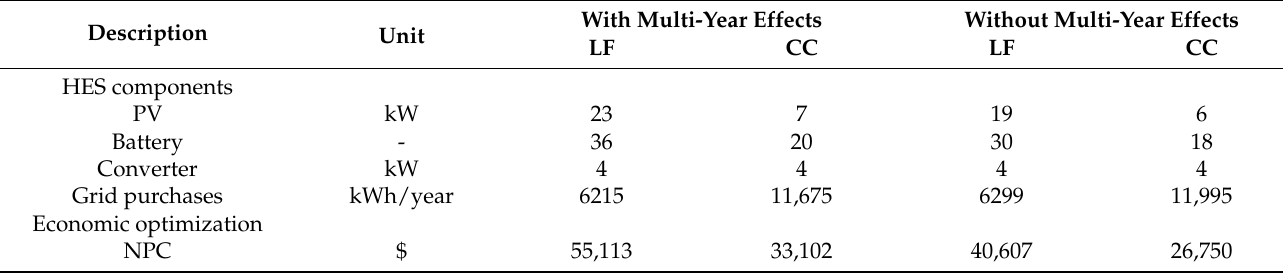
Table 5. Optimal HESs using LF and CC